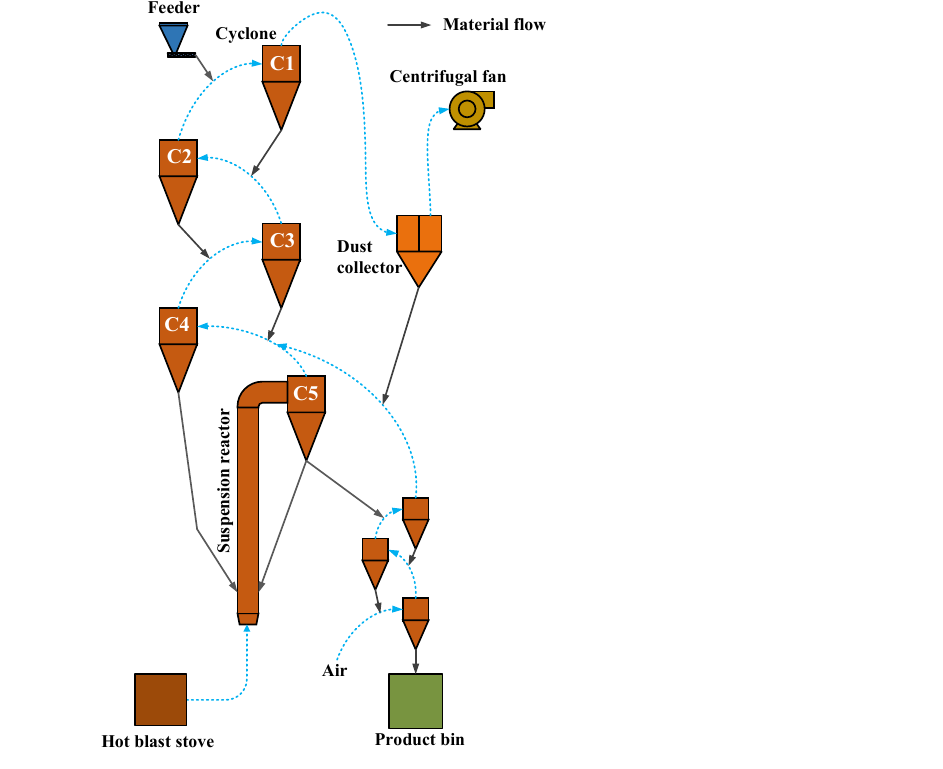
Figure 2. Conveyor bed magnetization roasting process system.